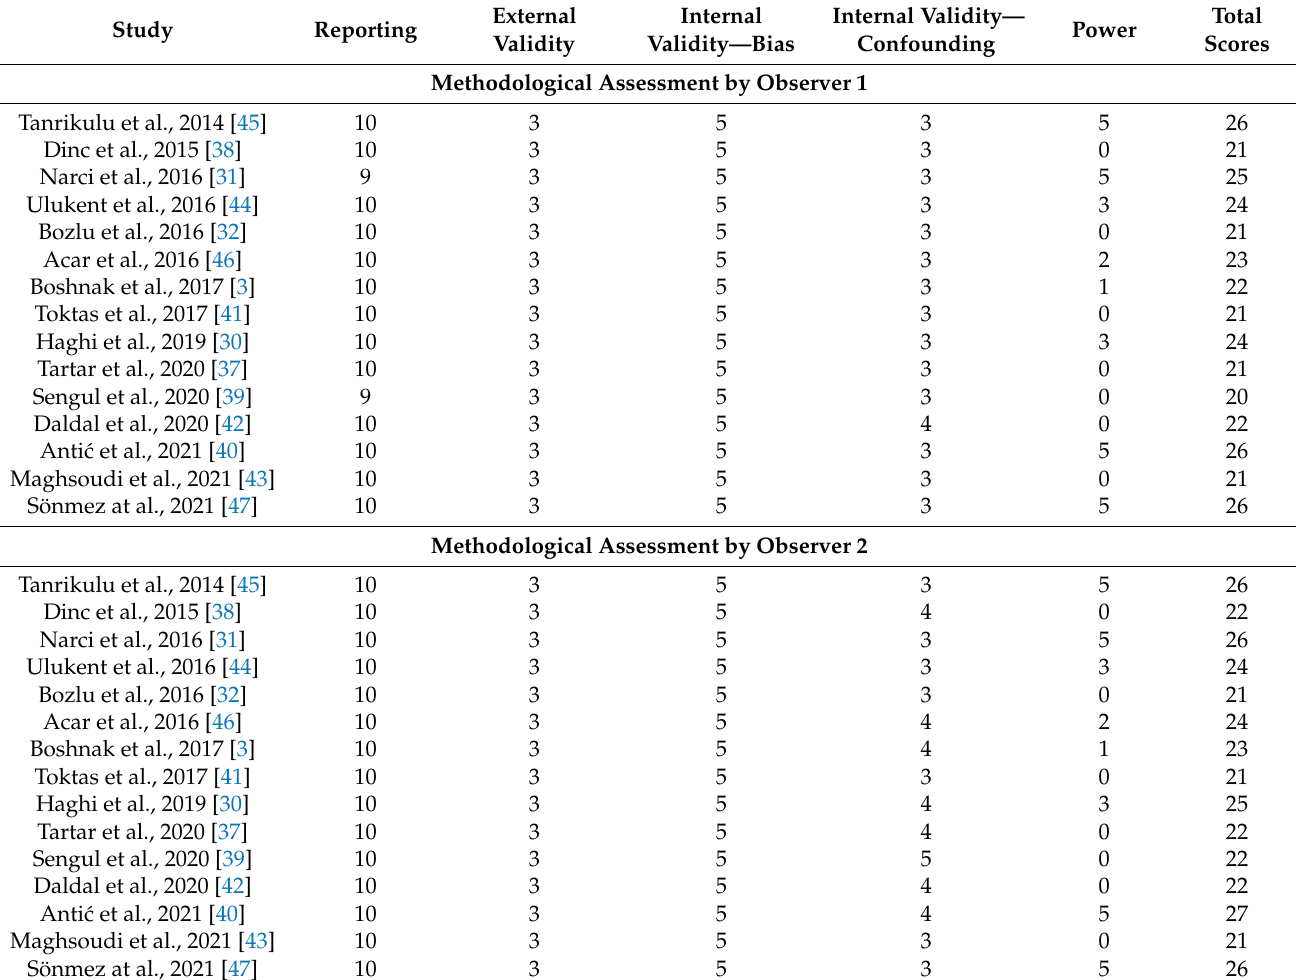
Table 2. Downs and Black scale scores for the included studies by Observer 1 and Observer 2.